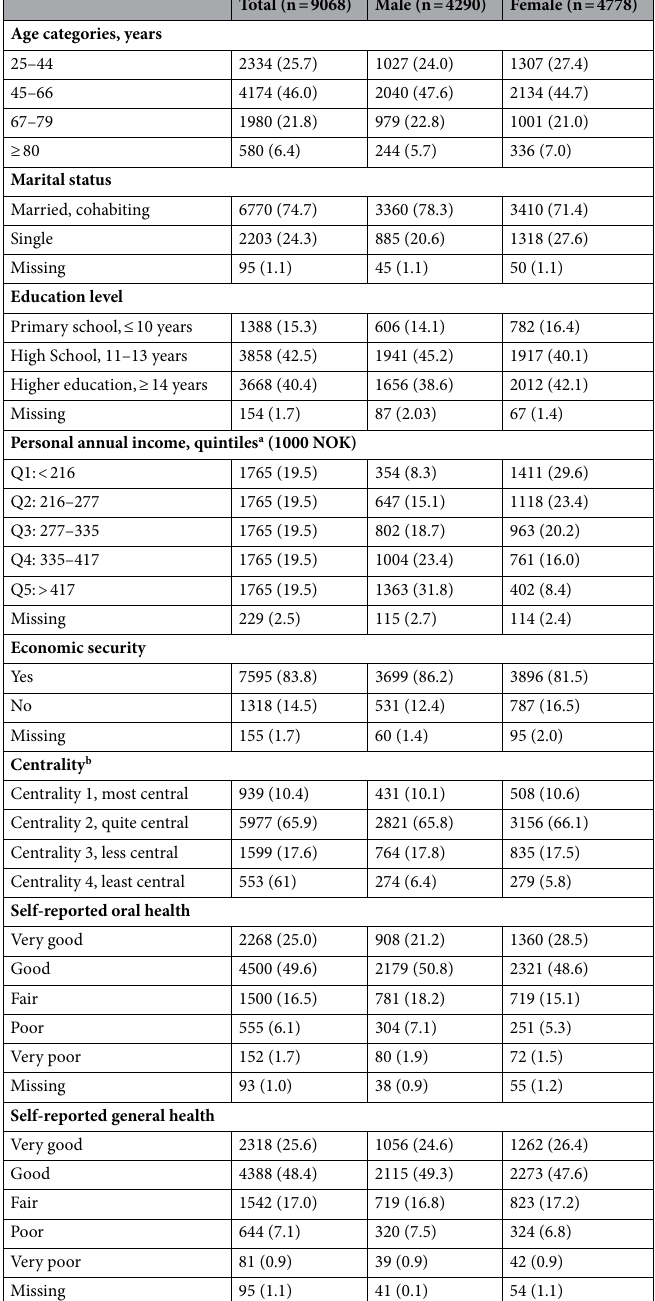
Table 1. Baseline description of the study sample. a 14 cases were incorrectly recorded, therefore they were excluded from the analysis for variable ‘income’. b Centrality (1–4) is influenced by travel time to work and the availability of service